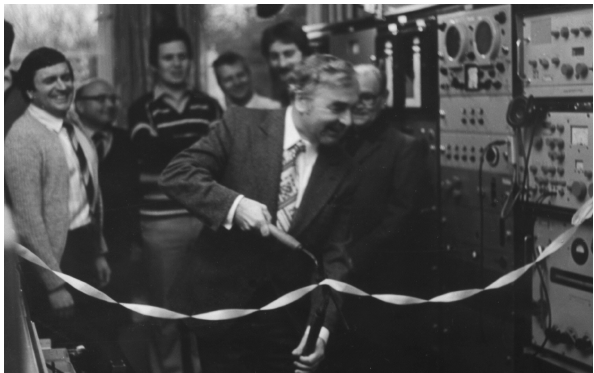
Figure 41. Prof. Dr. Jens Taubenheim sets in operation the MF radar, Juliusruh, 1982.